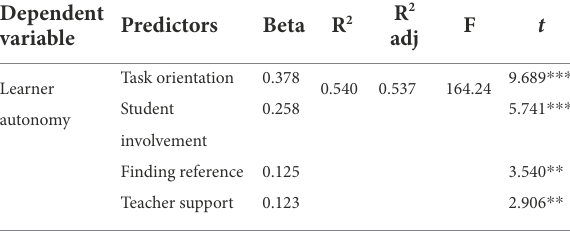
TABLE 5 Results of multiple regression analysis between English classroom environment and learner